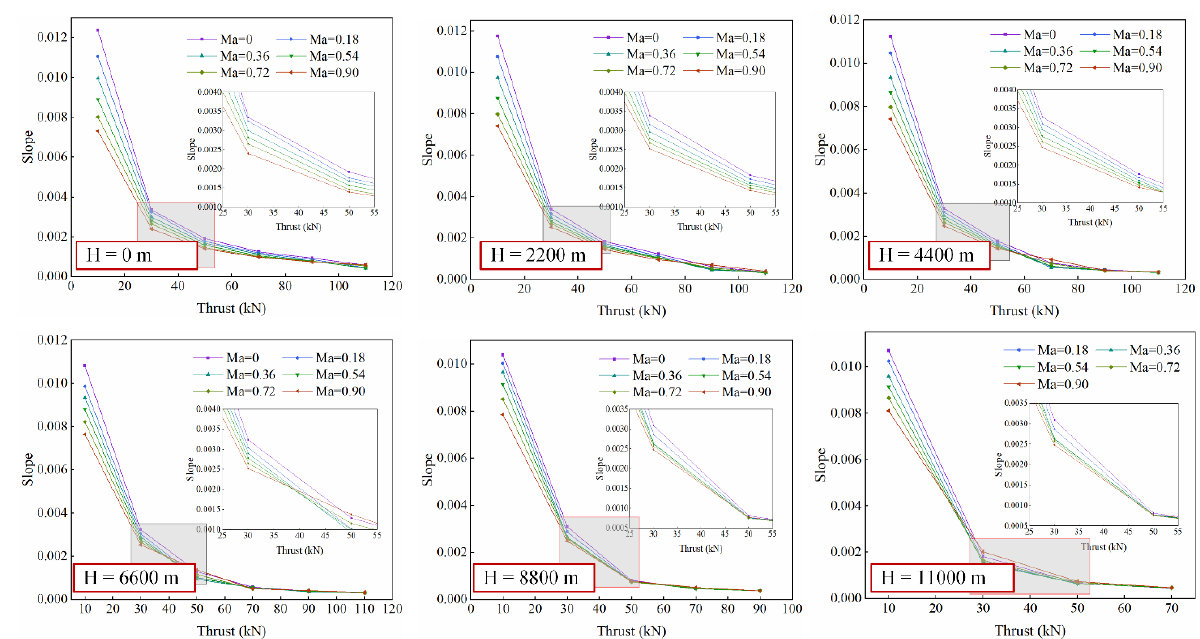
Figure 5. Influence of bleed air on the slope of the fitted line.